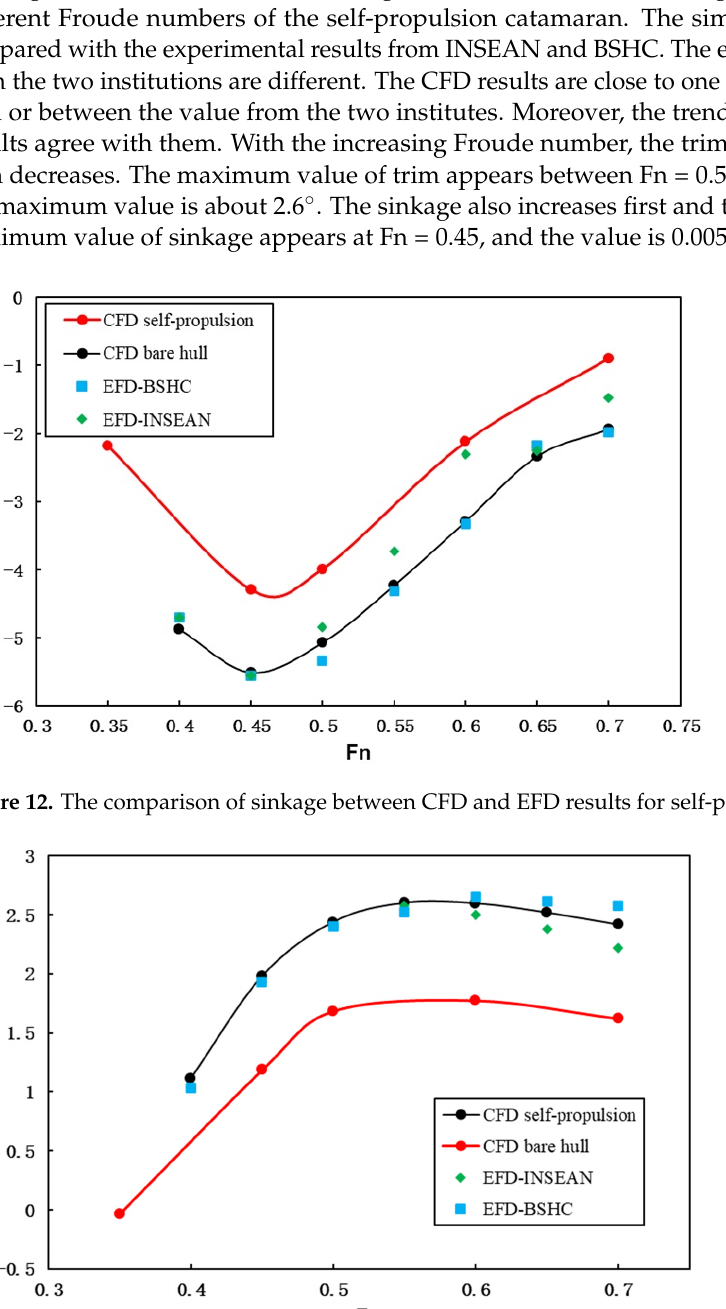
Figure 11. Comparison of the sinkage between CFD and EFD results.